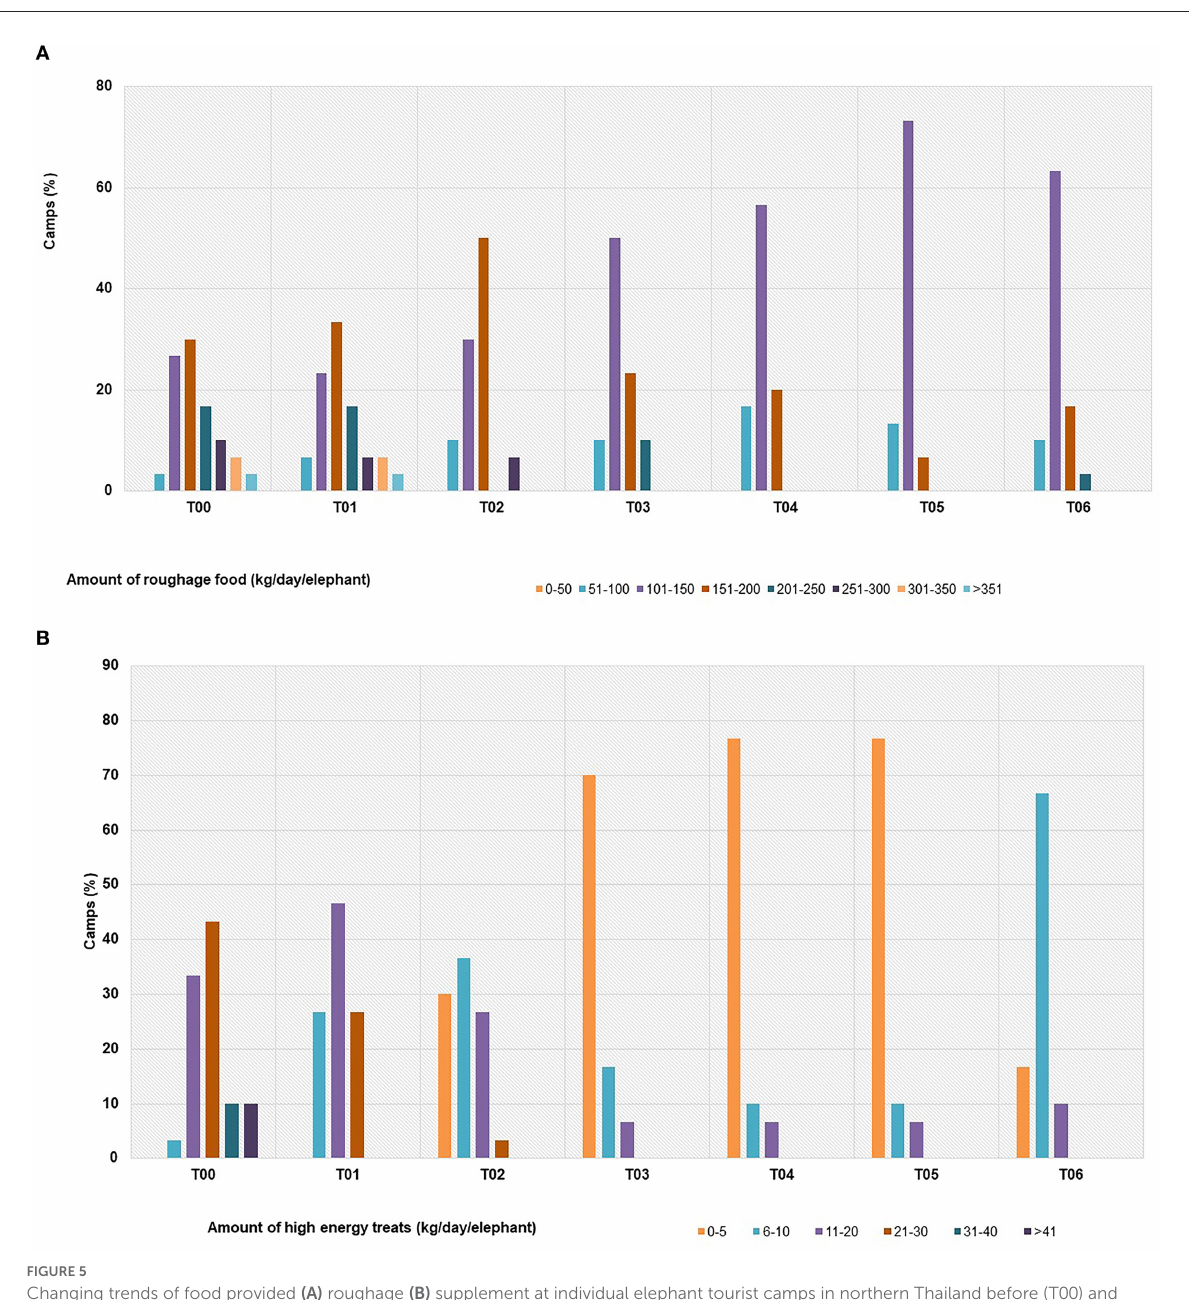
(September–December, 2021) and T06 (January-April, 2022)] during the COVID-19 pandemic. Types of high energy treats are described in Supplementary Figure